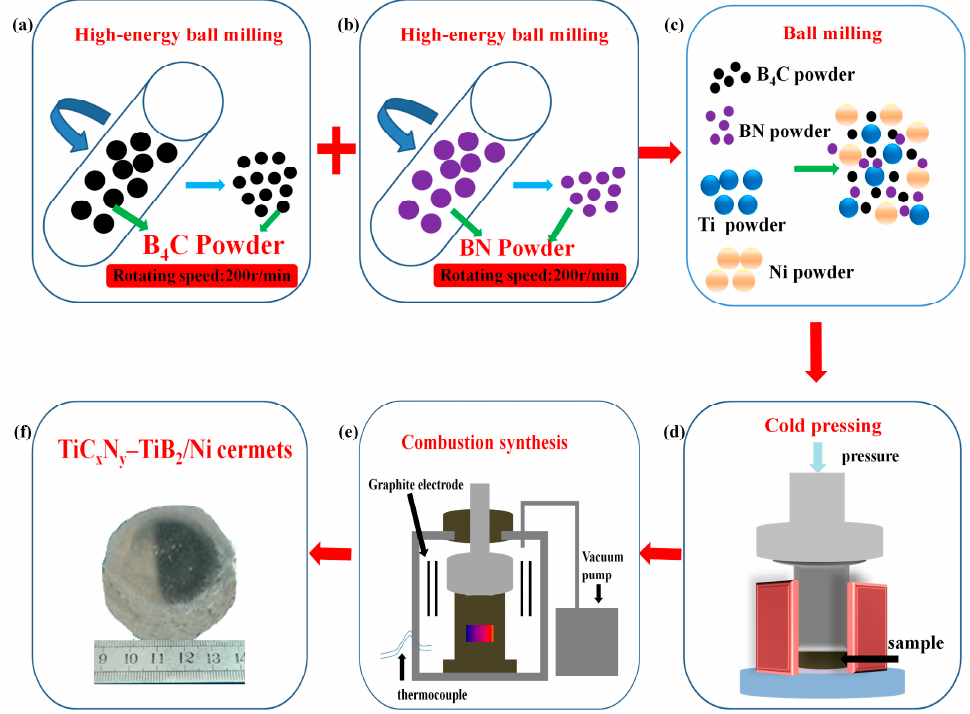
Figure 1. Schematic diagram of the preparation principle of the (TiC x N y –TiB 2 )/Ni cermets. ( a ) High-energy ball milling of B 4 C powder. ( b ) High-energy ball milling of BN powder. ( c ) Ball milling treatment of mixed powders. ( d ) Cold pressing mixed powders into a cylinder. ( e ) Preparation of micro-sized (TiC x N y –TiB 2 )/Ni cermets by hot press sintering of the compacts. ( f ) Sample of (TiC x N y –TiB 2 )/Ni cermets.